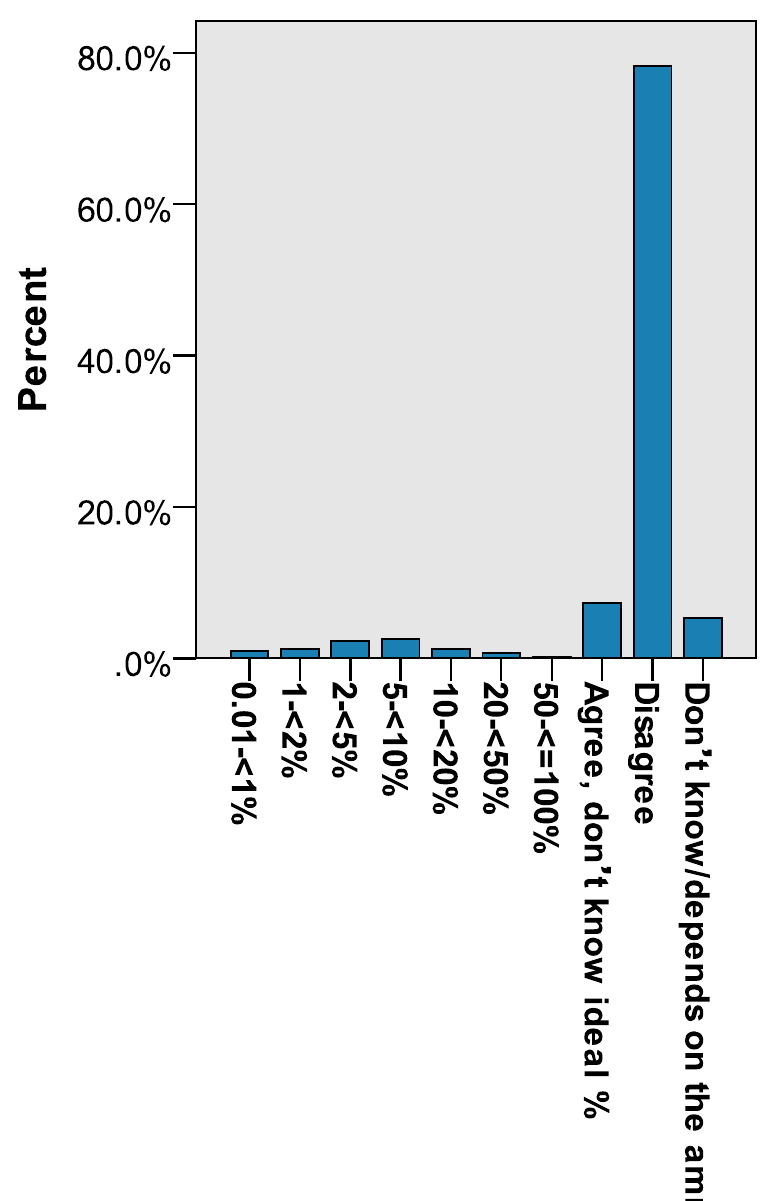
Fig 2. Percent of n = 950 respondents’ answers to: Do you agree or disagree that some government budget should be allocated to Foreign Aid for Social Development? If yes, what would be the ideal percentage?